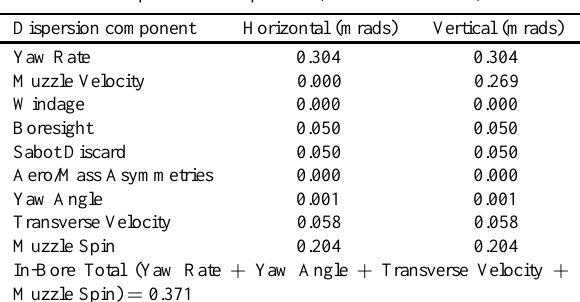
Table 4 Components of dispersion (from simulation #3)